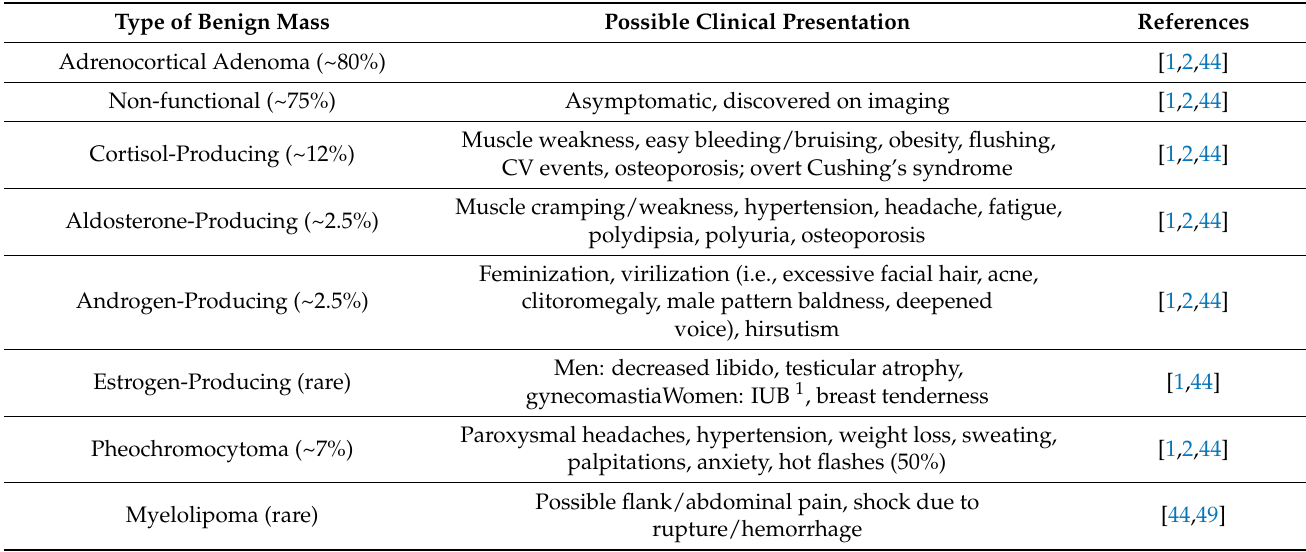
Table 1. Differential diagnosis for adrenal mass—benign